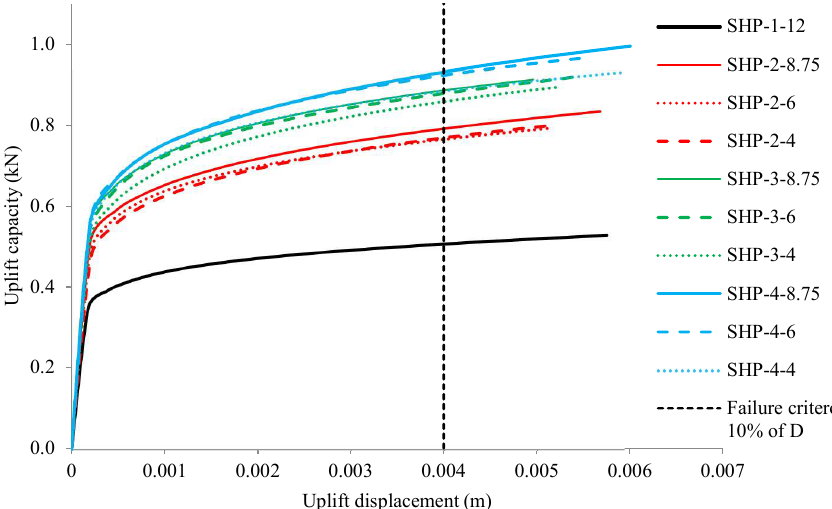
Figure 7. Load–displacement curve for uplift capacity of helical pile.